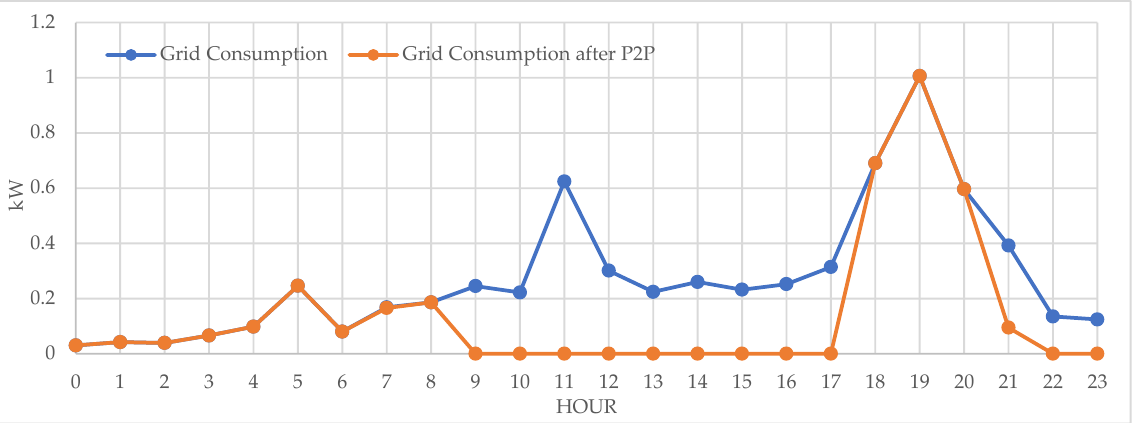
Figure 12. Reduction of exchange of electricity with the utility grid. Table 3 indicates that the consumer deducts 17.54% of the electric bill on a typical day in July. The interaction with the grid has been also reduced by 49.53%. Table 3. Comparison between original exchange and modified exchange with the grid in a typical